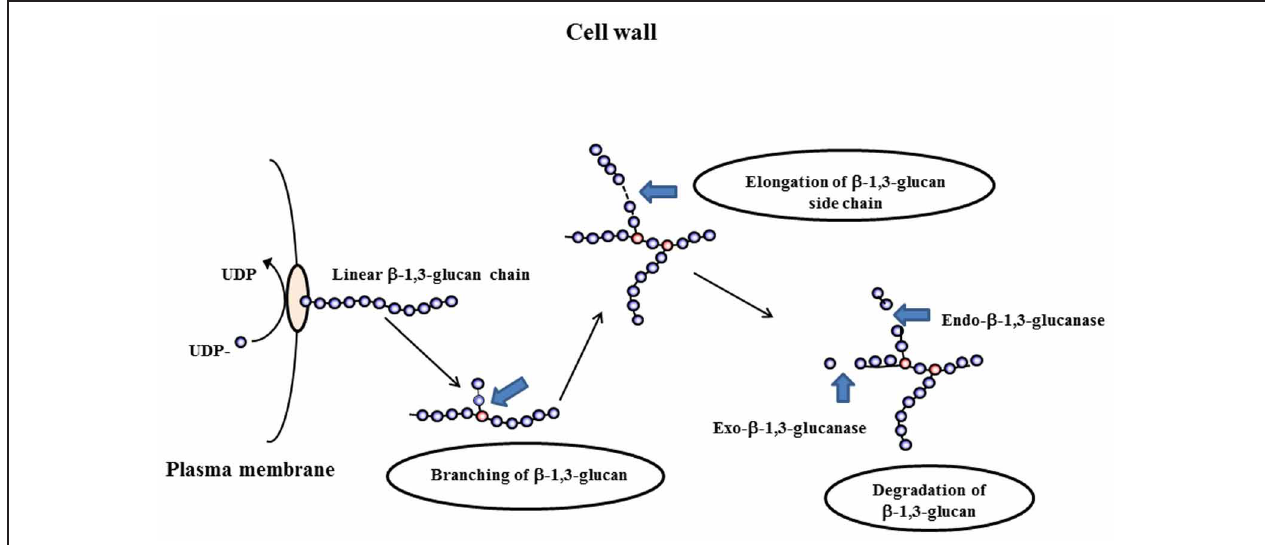
FIGURE 1 | Differents steps occurring during the remodeling process of the cell wall: branching of β (1–3)glucan, elongation and degradation of β (1–3)glucan